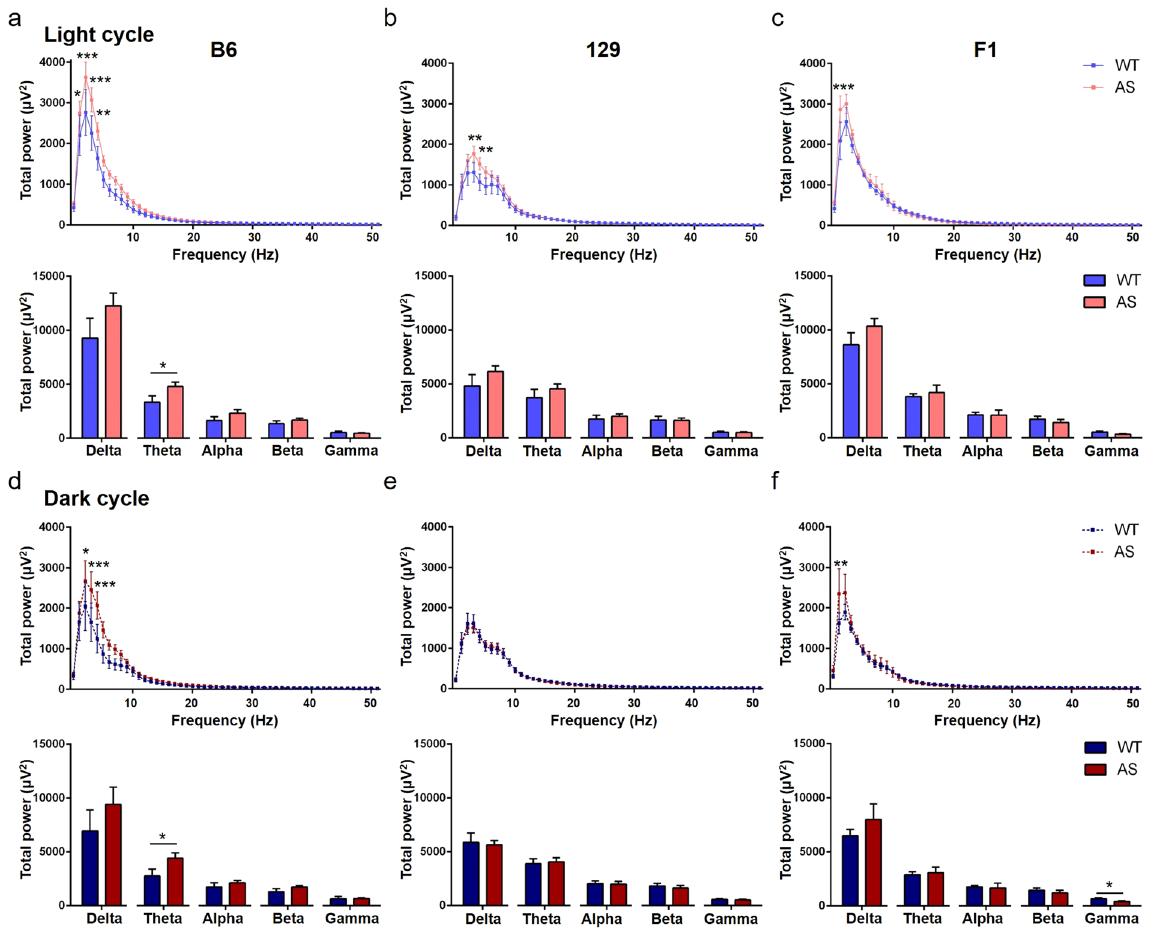
Figure 10. Detailed analysis of EEG spectral hippocampal power during a representative hour of the light cycle ( a–c ) and dark cycle ( d–f ) from AS mice compared to Wt mice. ( a,d ) There was an upward shift of the B6 AS mice spectral hippocampal power compared to the B6 Wt mice during both dark and light cycle. Increased power was seen in individual frequencies in the delta range and the summed theta bands (n = 9–11/group). ( b,e ) An upward shift in power was also seen in 129 AS compared to 129 Wt mice during the light cycle (B), driven by increased power in individual frequencies in the delta range, although no significant differences were seen in the summed frequency bands (n = 8–10/group). Hippocampal EEG activity during the dark cycle ( e ) was similar for 129 Wt and AS mice. ( c,f ) A significant increase in power at 1 Hz was seen during both light ( c ) and dark ( f ) cycles, while a significant decrease in the summed gamma spectral band was found in F1 AS mice only during the dark cycle ( f ) (n = 3–6 / group). 2-way ANOVA was used to compare the individual frequencies across the spectrum. Student’s t-test was used to compare between individual frequency bands and data are presented as the mean ± SEM; * p < 0.05, ** p < 0.01, *** p <